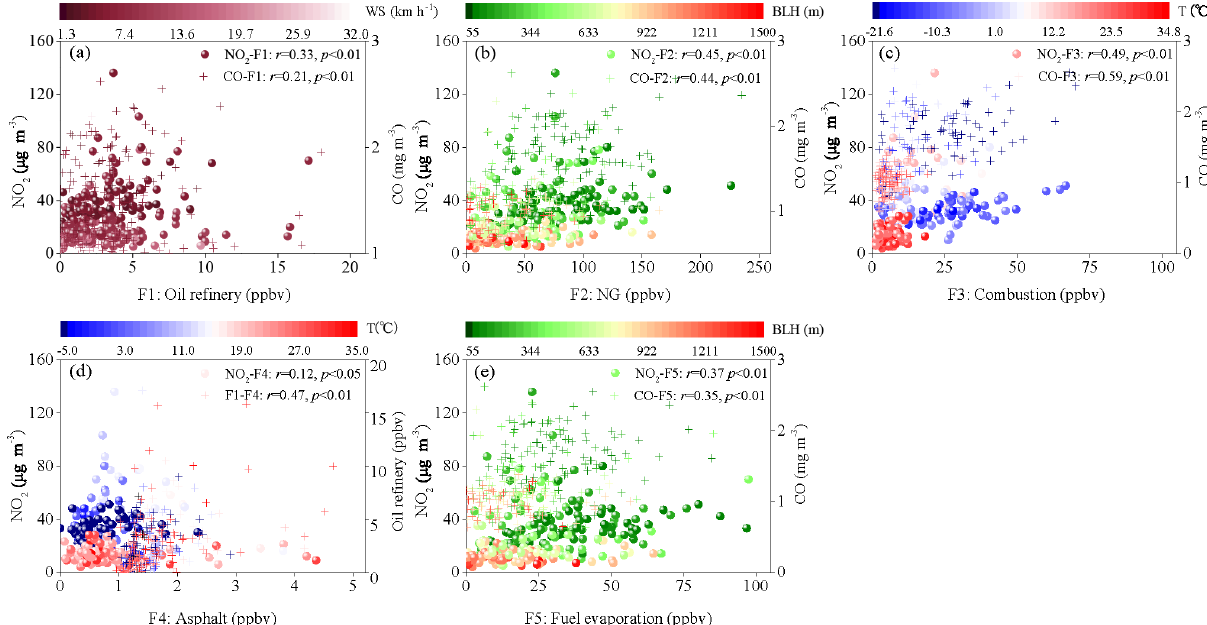
Figure 12. Scatter plots of daily concentrations of trace gas and source contributions including oil refineries (a) , NG (b) , combustion (c) , as- phalt (d) and fuel evaporation (e) under different meteorological conditions (wind speed, WS; boundary layer height, BLH; and temperature, T ).